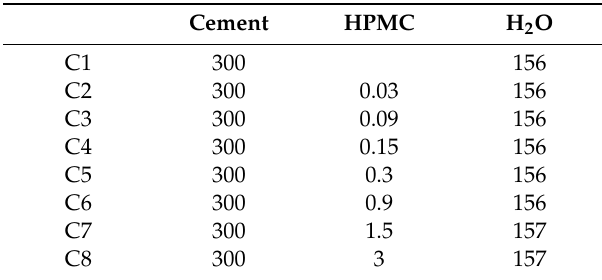
Table 3. Mixture proportions of cement paste